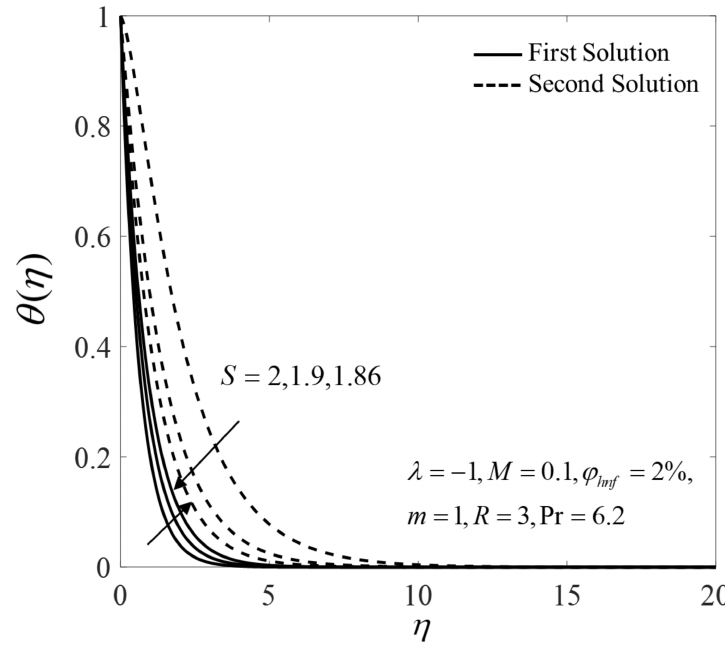
Figure 11. Temperature profiles θ ( η ) for different values of S